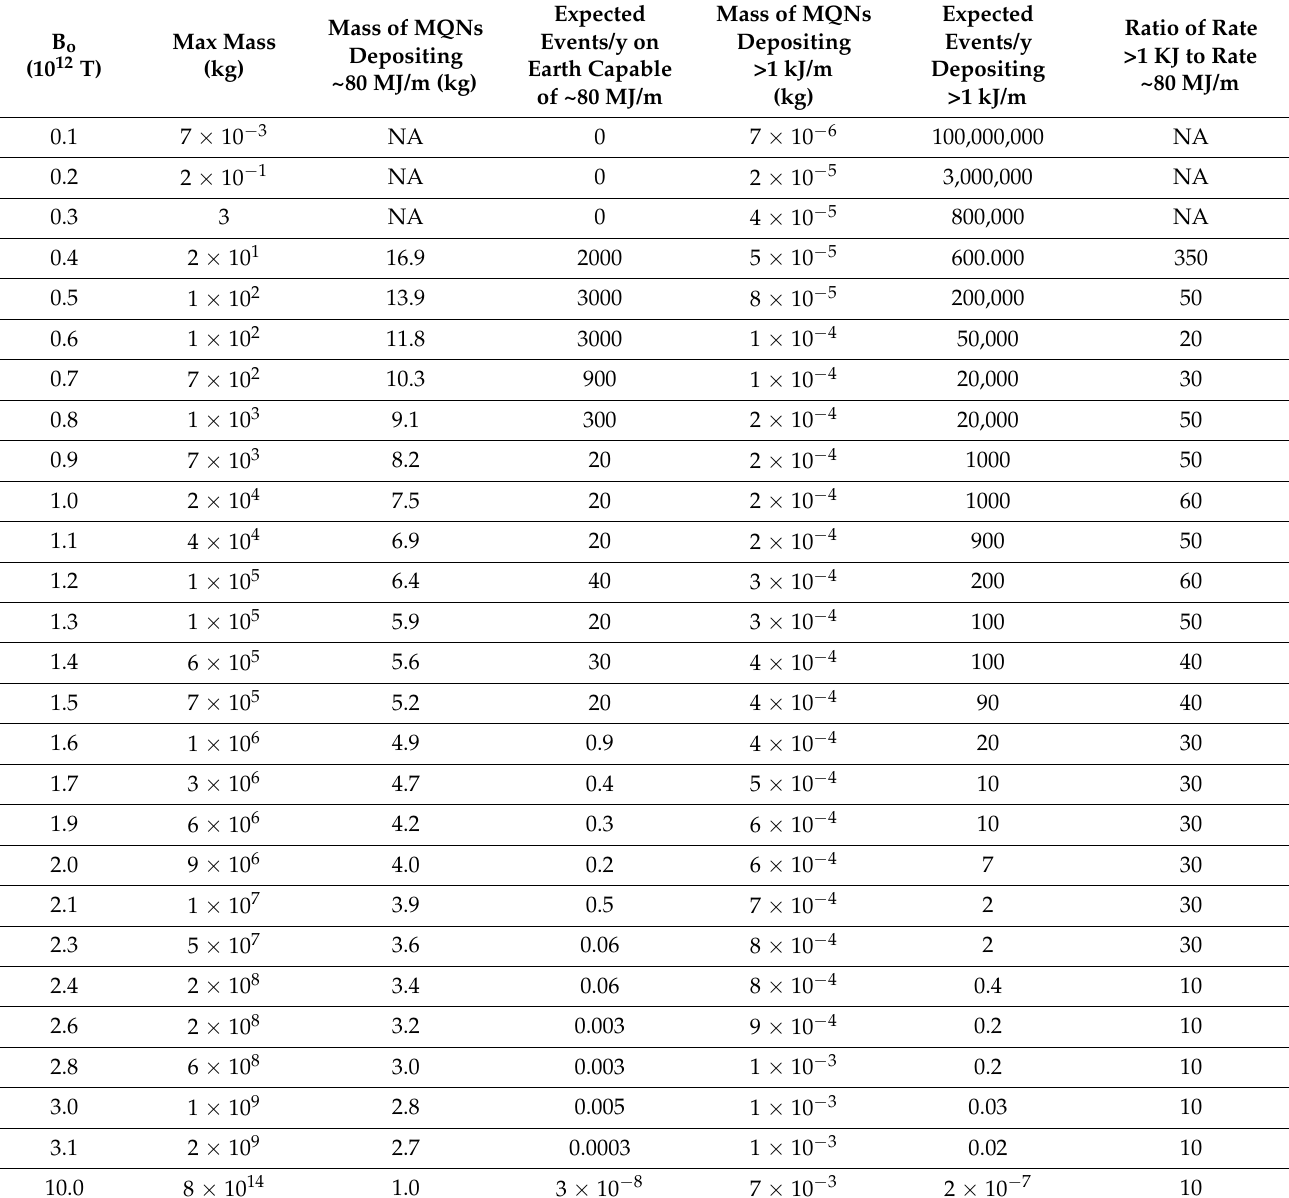
Table 1. Maximum mass, mass capable of delivering 80 MJ/m and 1 kJ/m, and an estimate of the corresponding event rates for interstellar dark-matter mass density ~7 × 10 − 22 kg/m 3 [1,6] and 250 km/s impact velocity, the relative velocity of the solar system through the dark matter halo. NA = Not Applicable and means that there was no